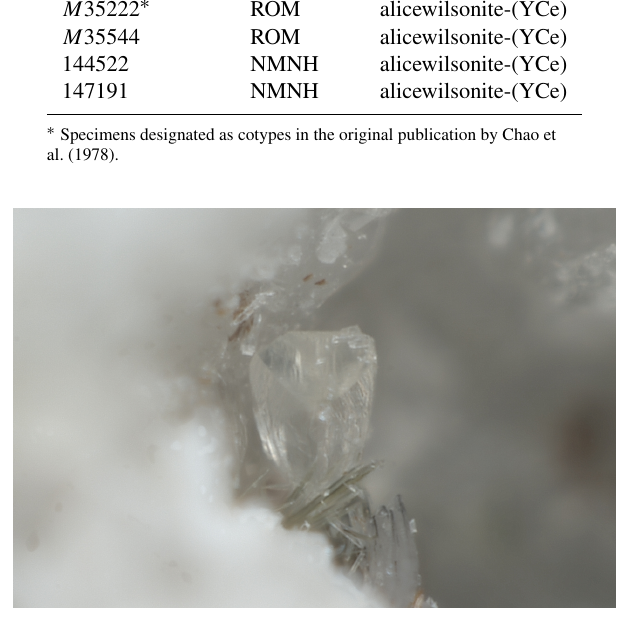
Figure 1. Colourless transparent donnayite-(Y) crystal, 0.2mm in size. Specimen CMNMC 39396. Photo: François